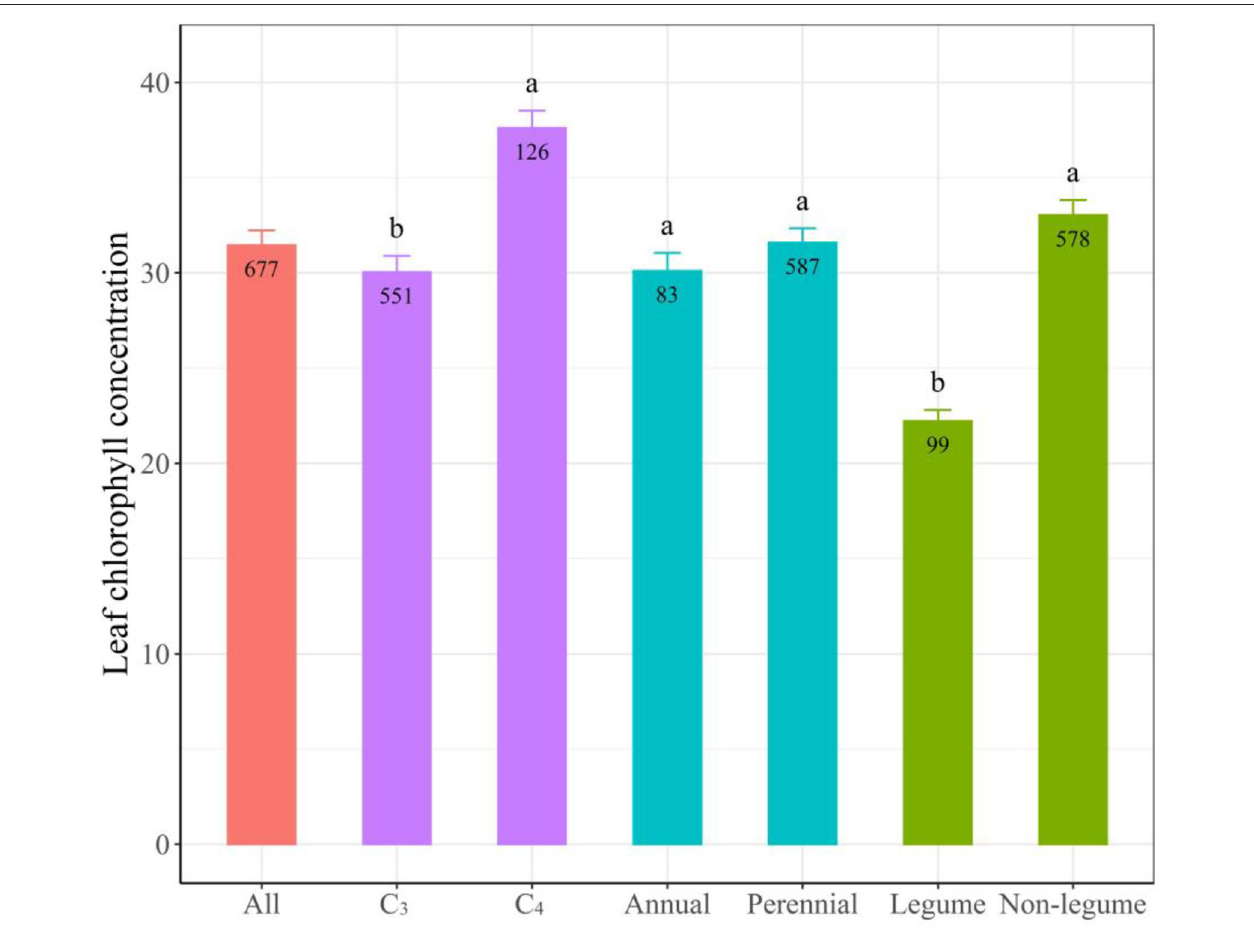
FIGURE 3 | Leaf chlorophyll (Chl) in different functional groups. Different colors represent different comparisons of functional groups, such as C 3 vs. C 4 species, annual vs. perennial species, or legume vs. non-legume species. Bar height indicates the mean of leaf Chl with its standard error. Different letters represent a significant difference among different functional groups. The numbers in the bar represent the observations of leaf Chl in different functional